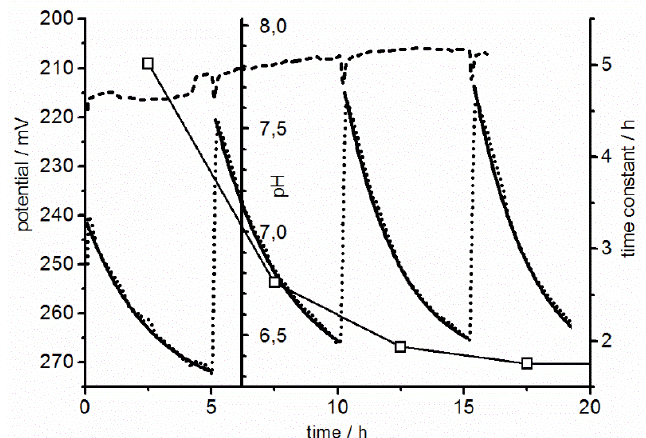
Figure 10. Exemplary measurements with a 60-nm pH sensor in a cell-free chip (reference) and under cell culture conditions. As a reference, three measuring cycles were conducted with cell culture medium of pH 7.8 (dashed line). Medium exchange events can be recognized by glitches every five hours. Using a two-point calibration, a drifting pH scale (shown at 6.2 h) can be obtained from the drifting reference potential at pH 7.8 (see text). With cells a steady acidification was observed after each medium exchange (dotted line). Fits of single exponentials (Equation (3)) led to time constants decreasing for increasing cell numbers (squares, referring to right